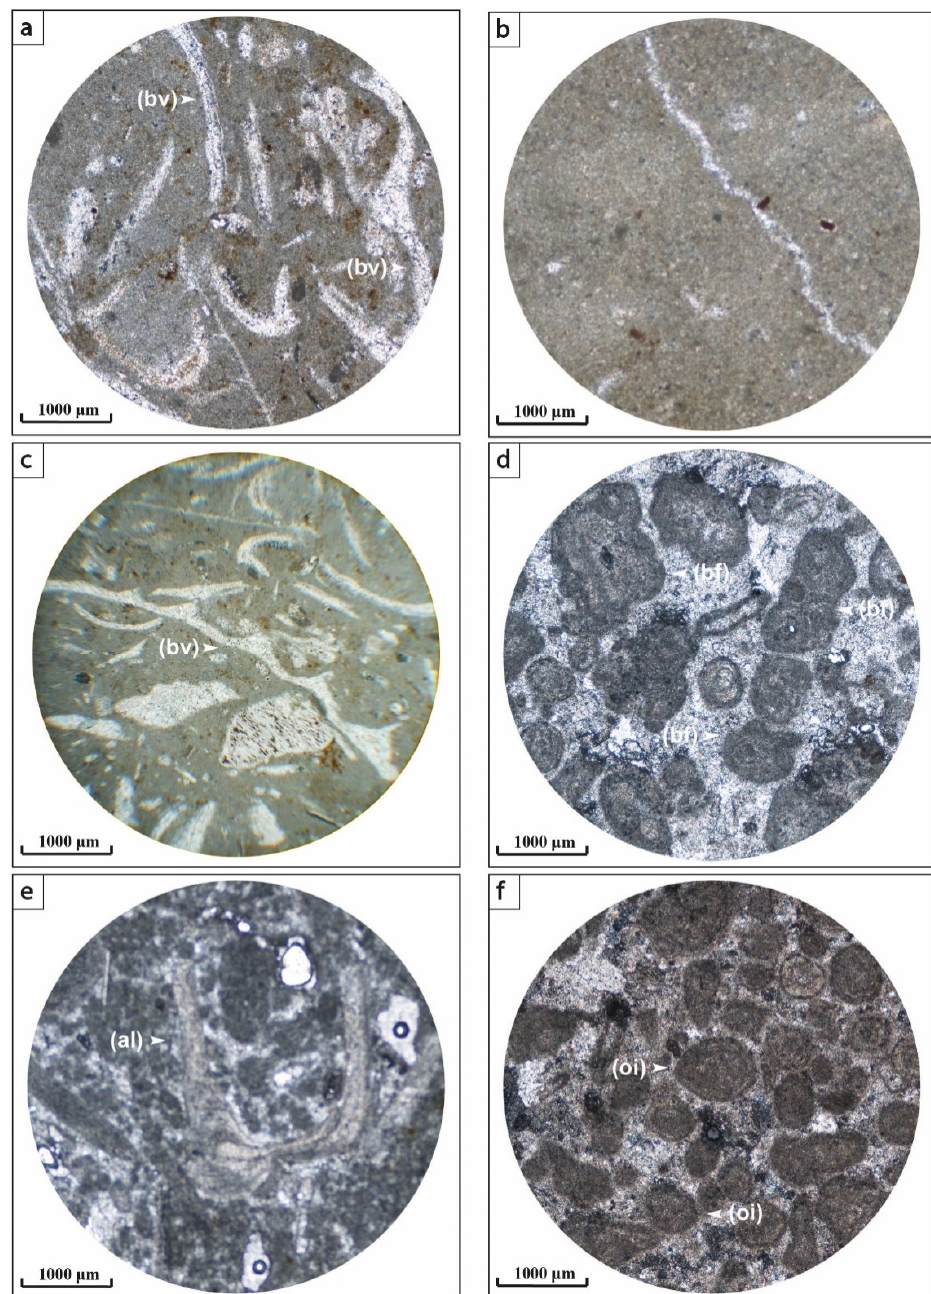
Figure 8. Thin section photographs of limestone microfacies of the Akrabou Formation in the Goulmima section. ( a ) packstone with bivalves (bv); ( b ) mudstone; ( c ) wackestone to packstone with bivalve fragments; ( d ) packstone with benthic foraminifera; ( e ) packstone microfacies with algae; ( f ) oolitic